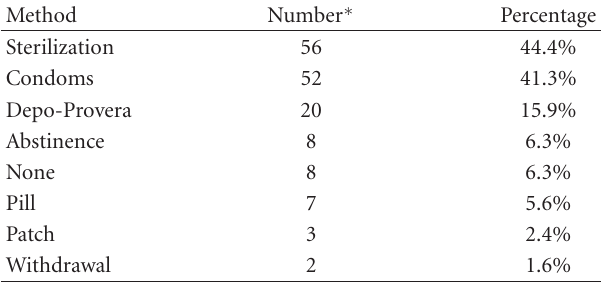
Table 2: Last contraceptive method used.